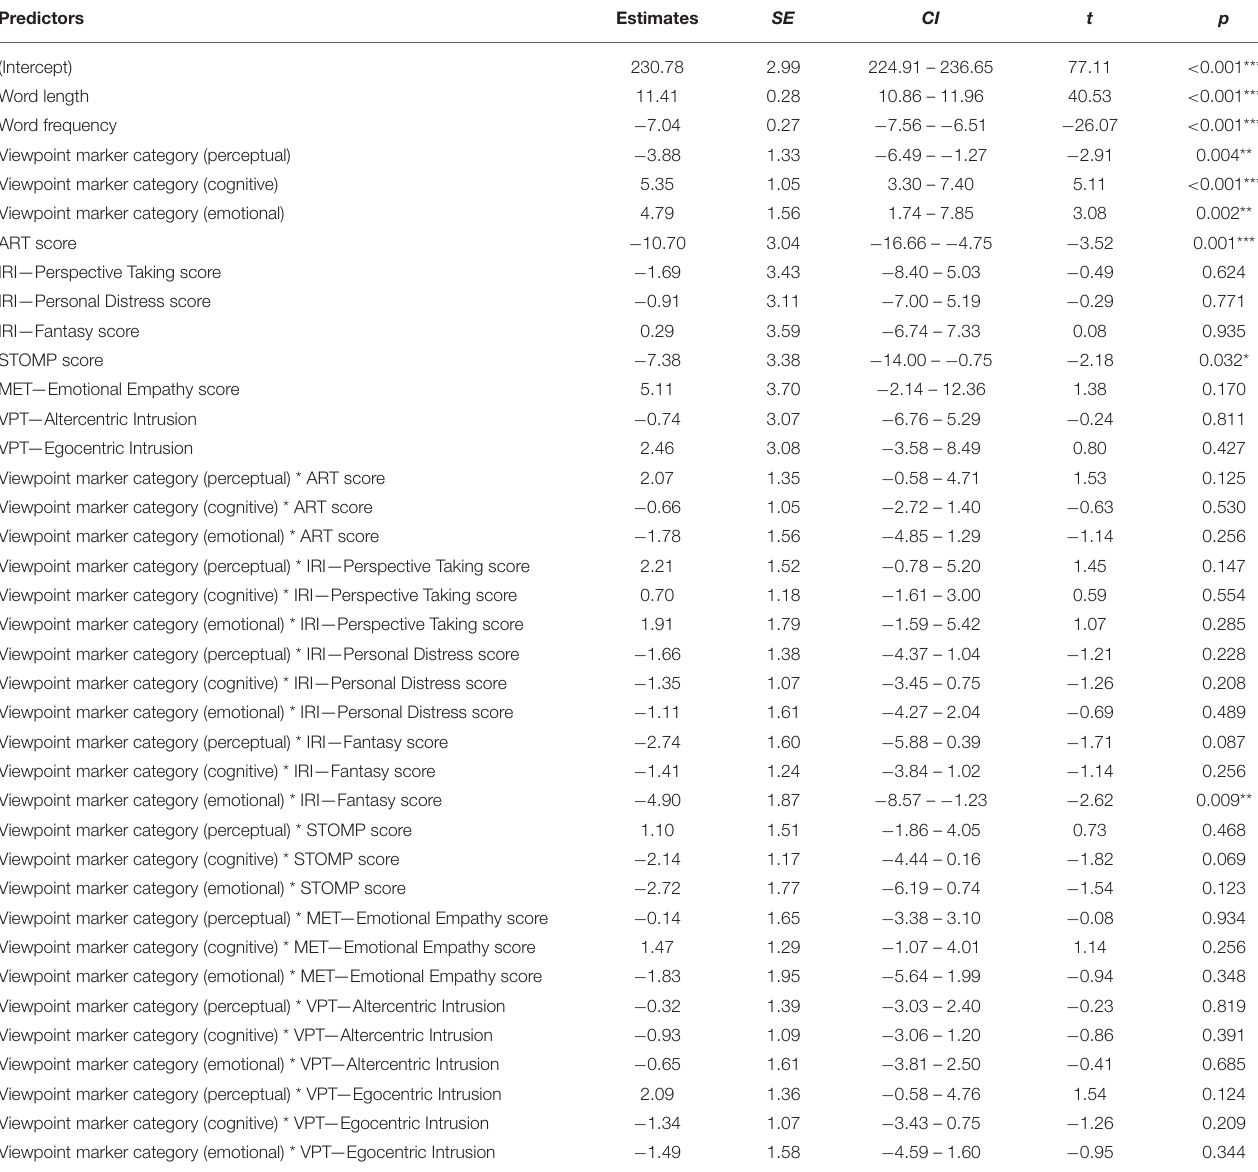
TABLE 5 | Estimates for the linear mixed model predicting gaze